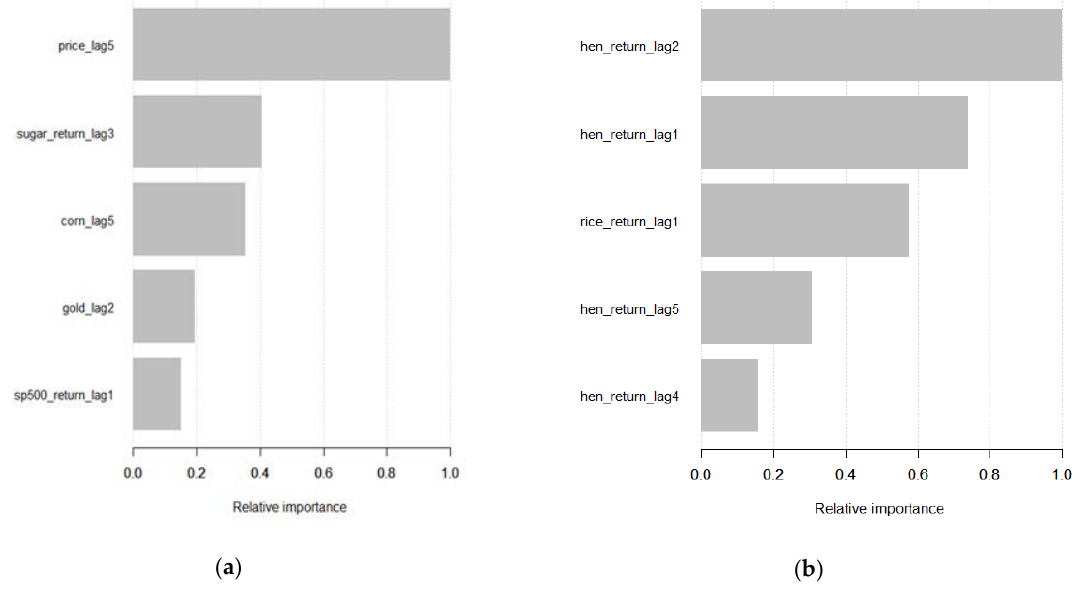
Figure A2 . XGboost variable importance plots: all variables with the moving window and the expanding window methods. ( a ) the XGboost variable importance plot of all variables with the moving window method in the final loop calculation; ( b ) the XGboost variable importance plot of all variables with the expanding window method in the final loop calculation.